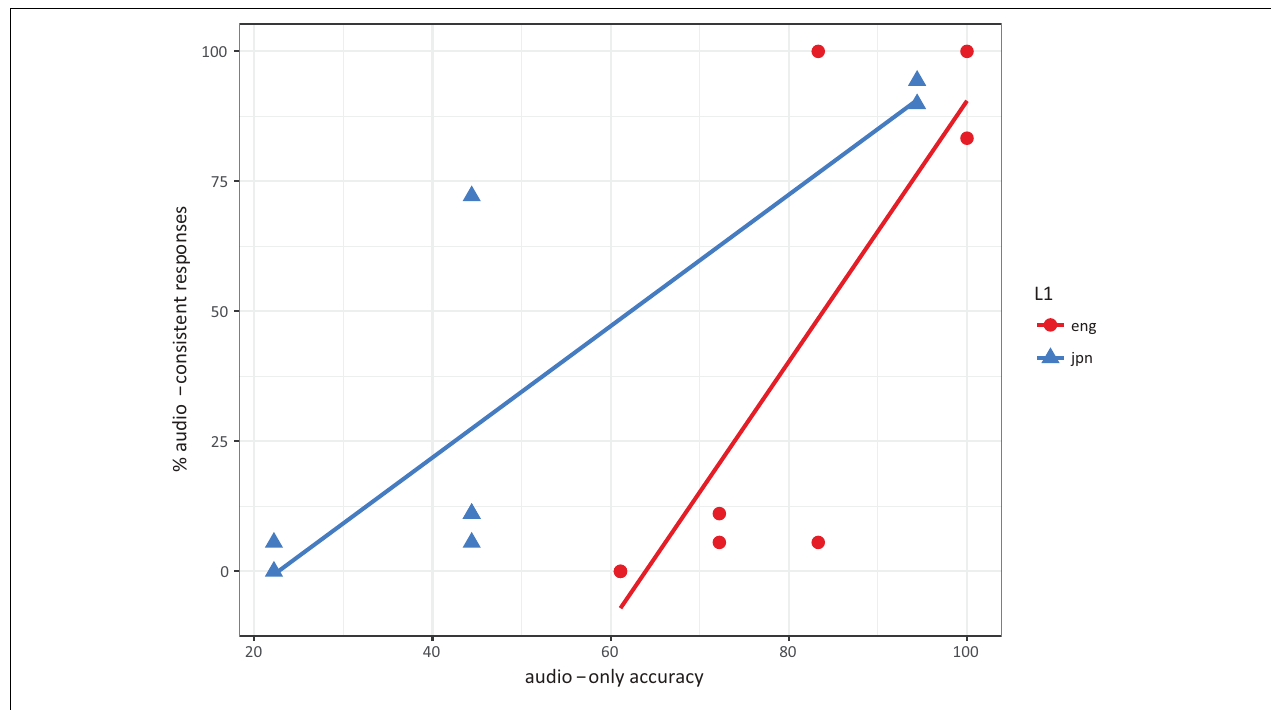
FIGURE 1 | Scatterplot of audio-only accuracy and audio-consistent responses across L1, syllable position, and consonants. Correlations were significant for both languages.